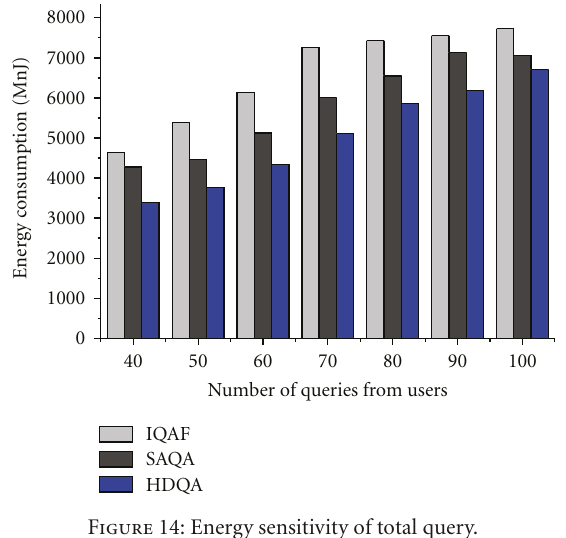
Figure 16: Energy sensitivity of historical query record.